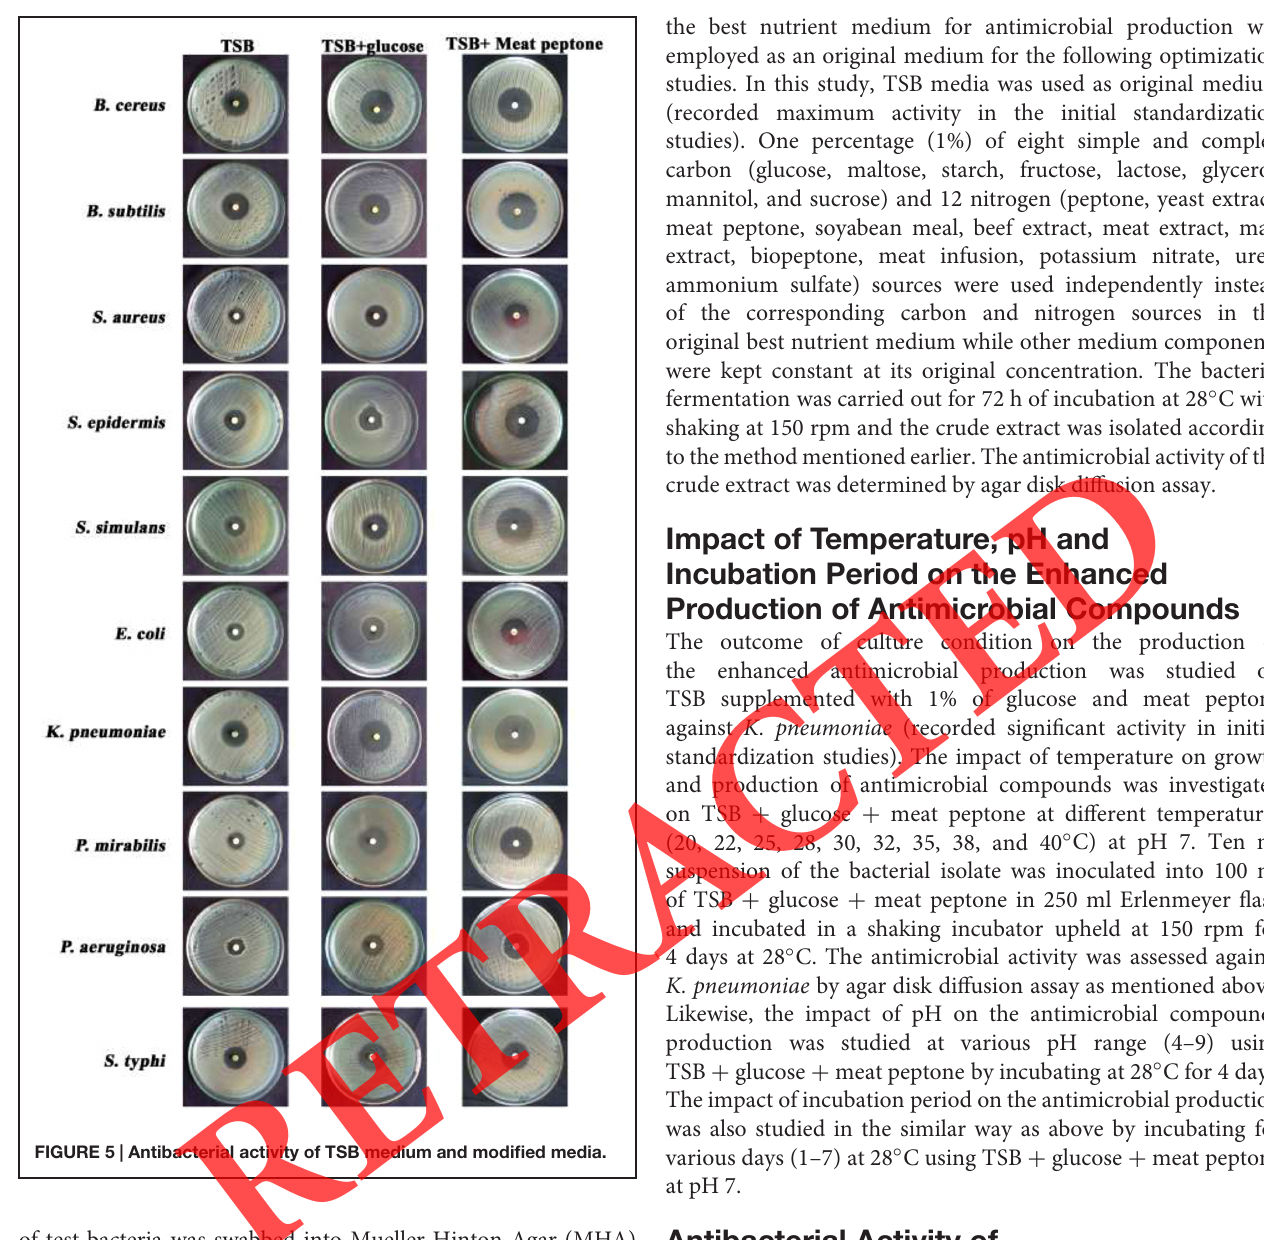
of test bacteria was swabbed into Mueller Hinton Agar (MHA) plate. The crude extract (100 μ l) following microfiltration using a 0.22 μ m syringe microfilter, were loaded on 6 mm sterile disk filters (Whatman 3-mm paper, Hi-media) and air dried. After 2